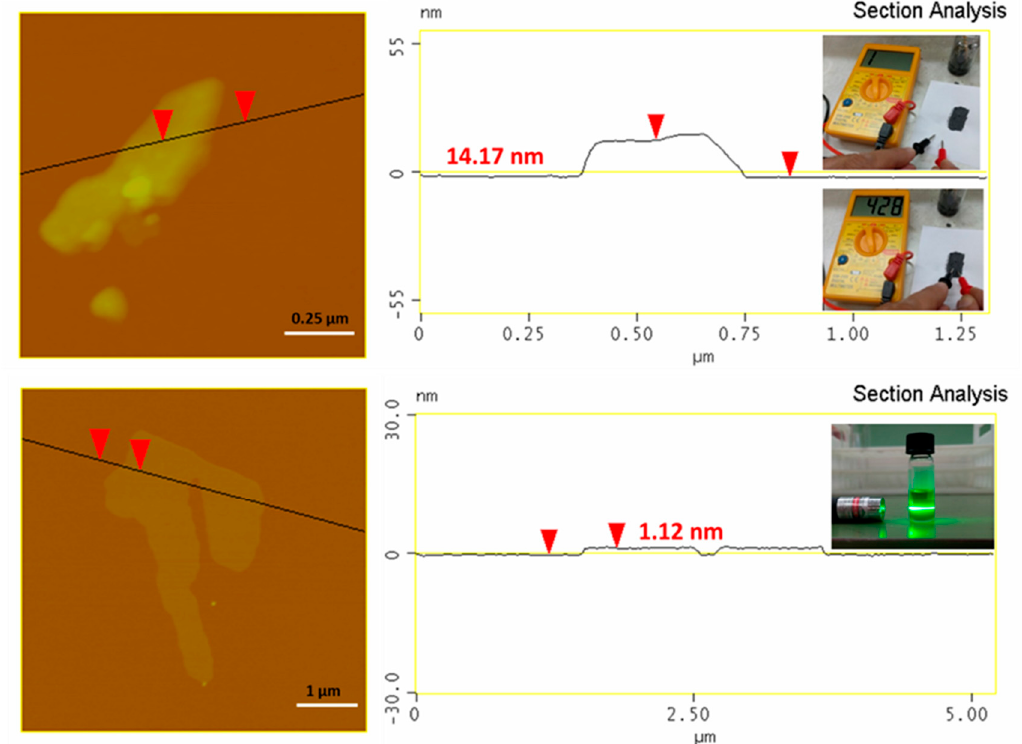
Figure 2. AFM images and height profiles of synthetic graphite ( top ) and derived graphene ( bottom ). The top inset shows the waterborne conductive ink made of water glass and synthetic graphite. The ink is applied on a piece of paper using a small paintbrush, leaving a flexible conductive trace after drying (note that paper itself is an insulator). The bottom inset shows the colloidal dispersion of graphene in DMF exhibiting a strong Tyndall effect.